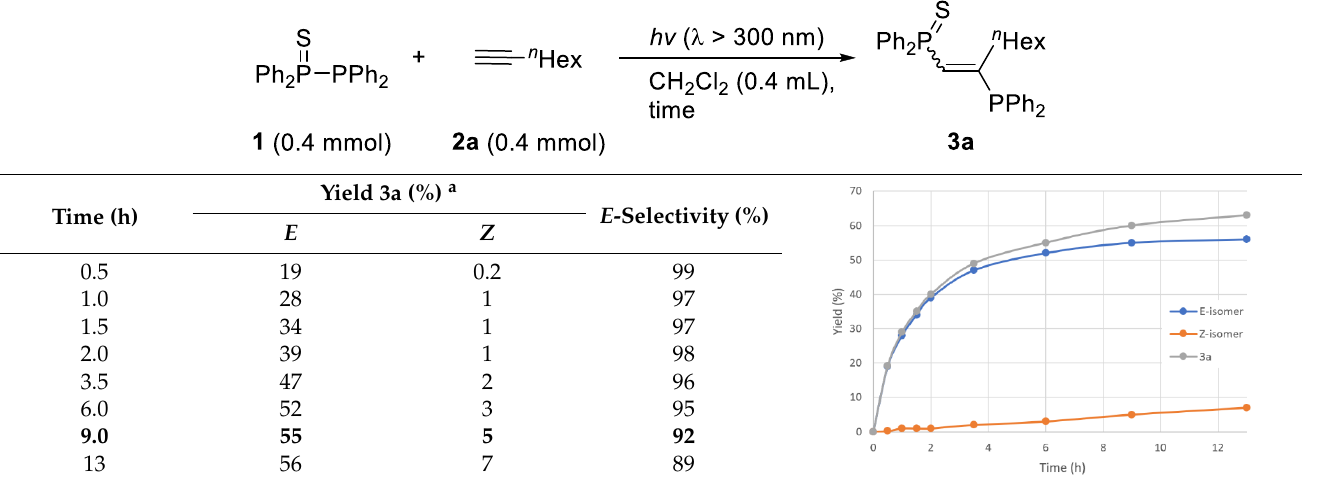
Table 1. Time-dependent profiles of the photoinduced bisphosphination of 1-octyne 2a .